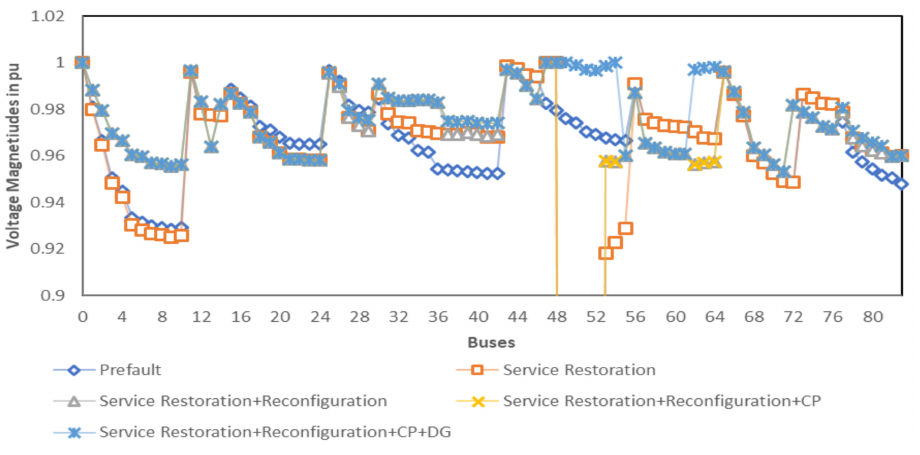
Figure 16. Bus voltage of test case 2 under CFC.